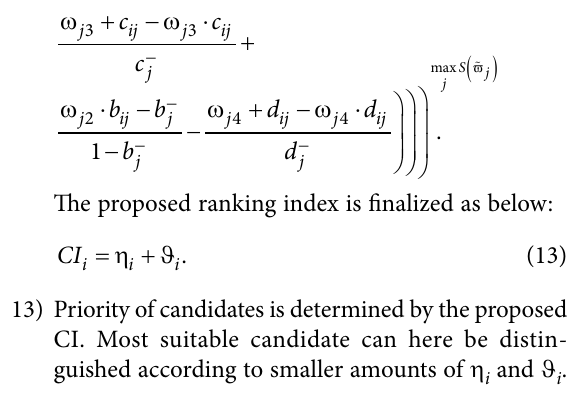
Figure 1. Logistics network under study